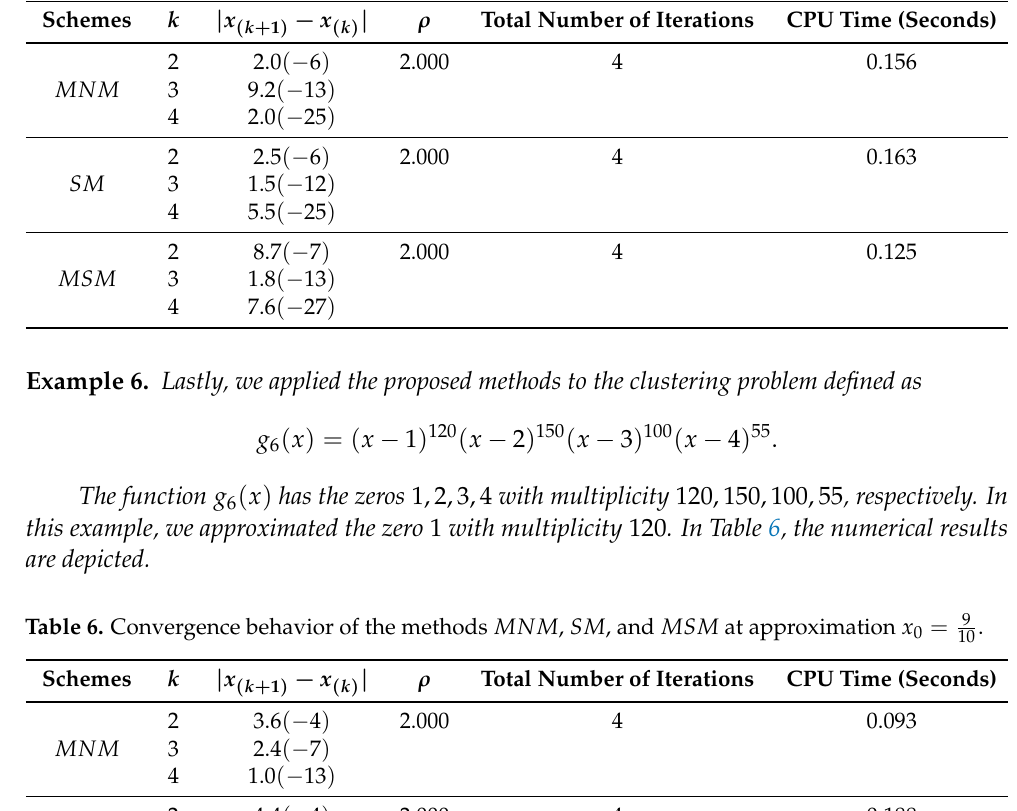
Table 5. Convergence behavior of the methods MNM , SM , and MSM at approximation x 0 = 31